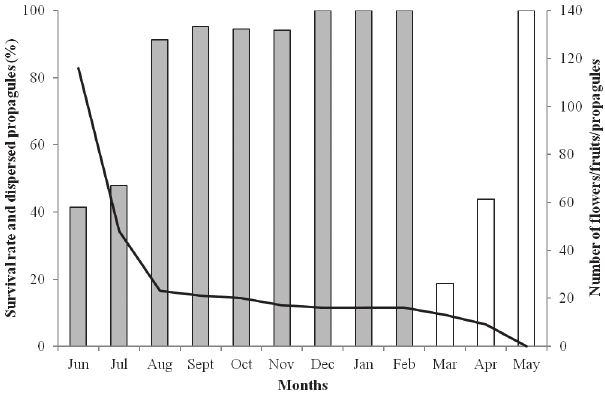
Fig. 4 - Survival rate and percentage of propagules of Rhizophora mangle (Rhizophoraceae) in dispersal in a mangrove area of goiana, Pernambuco, Brazil. The month of June corresponds to the stage of anthesis, July to the stage of the ovary under development, September and October to the stage of the fruit, and from November on to the propagule. ― Number of fl owers, fruits and propagules; ■ survival rate; □ percentage of dispersed